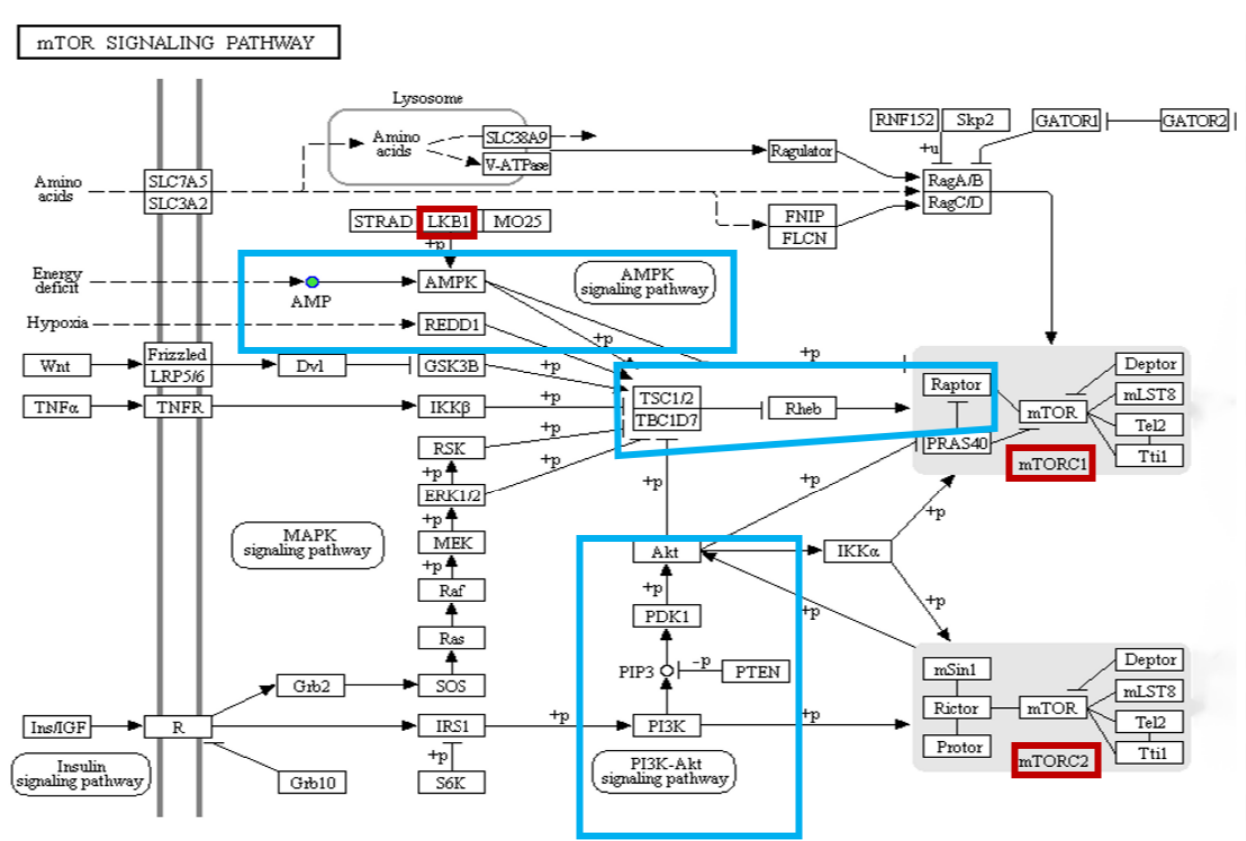
Figure 6. Schematic showing the mTOR signaling pathway under hypoxic stress. The main processes affected by hypoxia are boxed in blue, and the major regulatory factors are boxed in red.